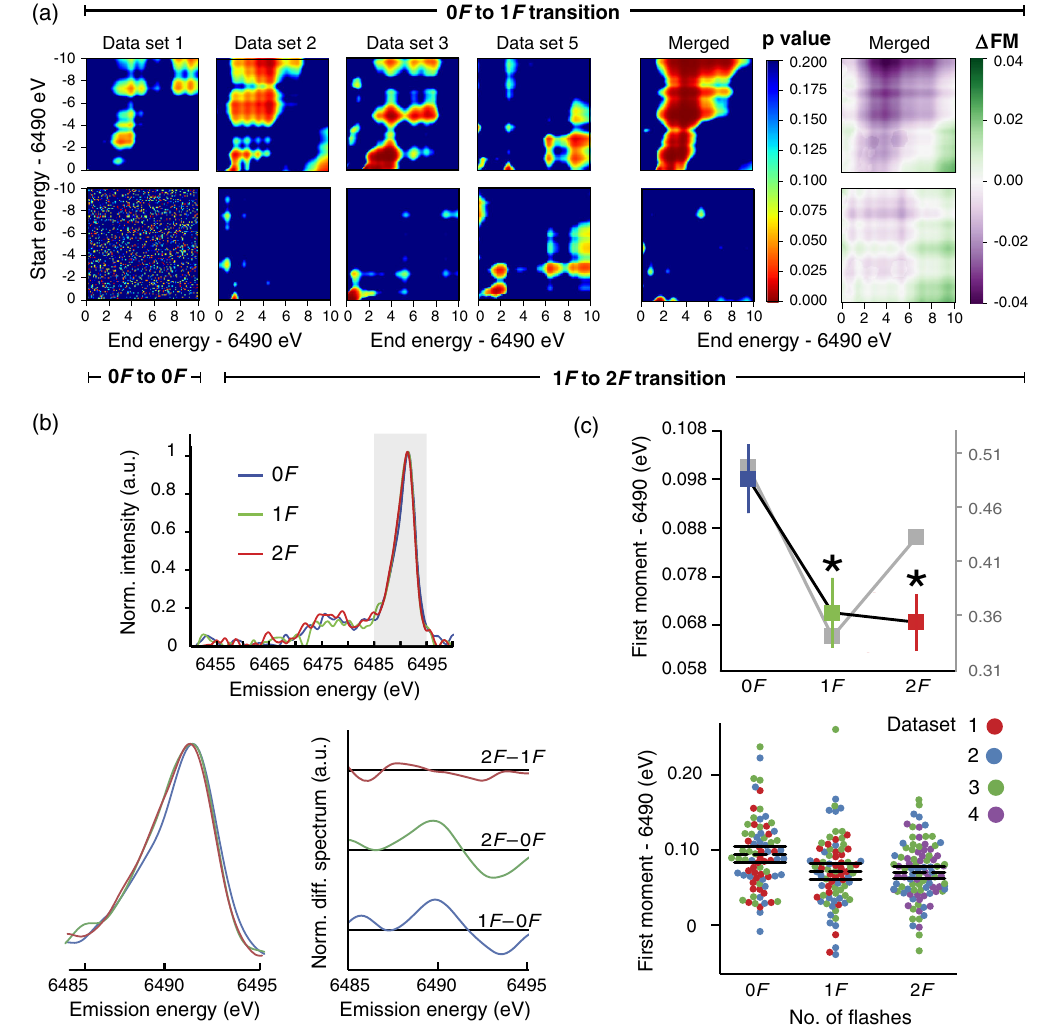
FIG. 2. Analysis of the statistical significance for S 1 → S 2 → S 3 transitions serves as a proof of concept. (a) Spectral shifts occurring as a result of 0 F → 1 F and 1 F → 2 F transitions are characterized using 2D heat maps, illustrating the p value (see Table S2 for n [5]) for changes to first moments calculated over the ranges defined by the x and y axes, i.e., start and end energy, respectively. Contours appear in plots comparing 0 F → 1 F data indicate a statistically significant difference. By contrast, limited low p -value regions are observed for the 1 F → 2 F transition, suggesting a smaller change. The directionality and magnitude of spectral shifts are shown in the − FM final column. These 2D heat maps, which graphically illustrate the change in first moments ( Δ FM ¼ FM ) calculated postflash preflash over the ranges defined by the x and y axes. 0 F → 1 F and 1 F → 2 F transitions are dominated by negative, or oxidative, shifts. An example of statistical noise is presented by randomly dividing a 0 F data set and performing the same analysis, e.g., 0 F → 0 F . Relevant data from data sets 1 – 4 are merged to generate the final columns. Note that 0 F and 1 F data are not collected for data set 4, while data set 5 is collected independently following a beam-line upgrade and is therefore analyzed separately; see Fig. S4 [5]. (b) Wavelet-transform smoothed and background-subtracted emission spectra for merged 0 F , 1 F , and 2 F data. The region (6.485 – 6.495 keV), over which the first moment is calculated, is highlighted, and a magnified inset as well as difference spectra are presented. Difference spectra are smoothed with a rolling average calculated over 14 points (approximately (cid:2) 0 . 7 eV). (c) (Top) Average first moments from unprocessed (color) and processed (gray) spectra. Errors are presented as SEM with n given in Table III. Those moments with a statistically significant difference ( p < 0 . 05 ) from 0 F data are indicated with an asterisk. (Bottom) Dot plot of first moments from raw data. Each dot represents a calculated first moment from a thread collected during the beam time corresponding to its color in the legend. Dashed lines represent the average first moment, while solid bars are the 95% confidence